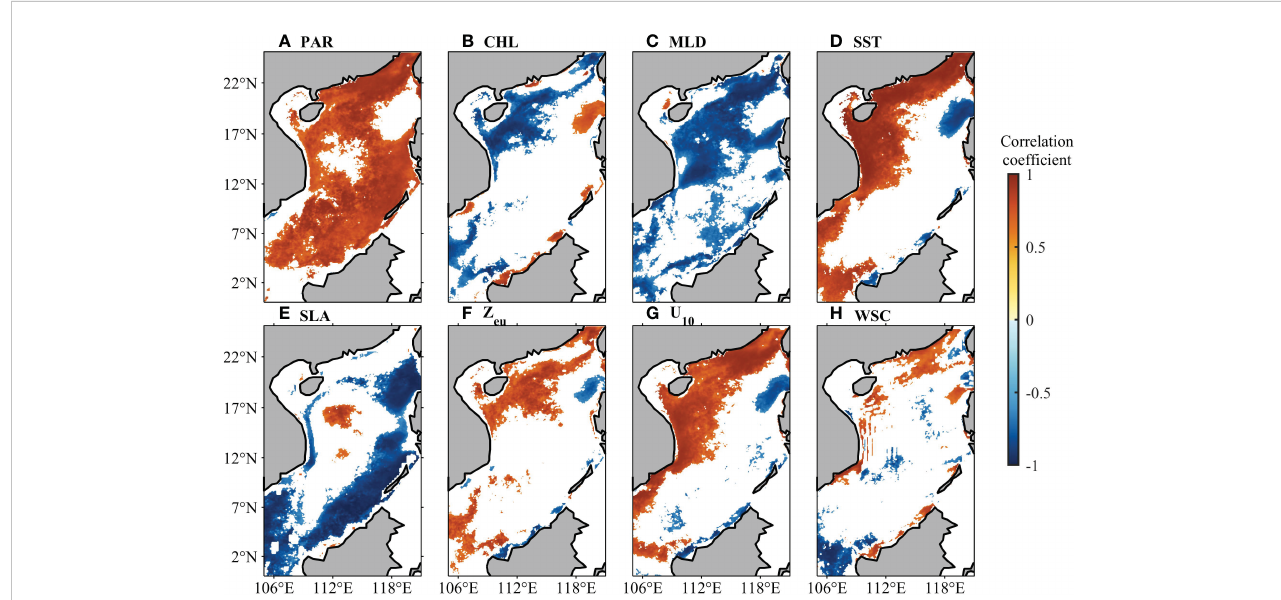
FIGURE 5 Correlation coef fi cients between monthly climatological NPP and (A) PAR, (B) CHL, (C) MLD, (D) SST, (E) SLA, (F) Z eu , (G) 10-m zonal wind speed (U 10 ), and (H) WSC. Locations with nonsigni fi cant correlations are plotted in